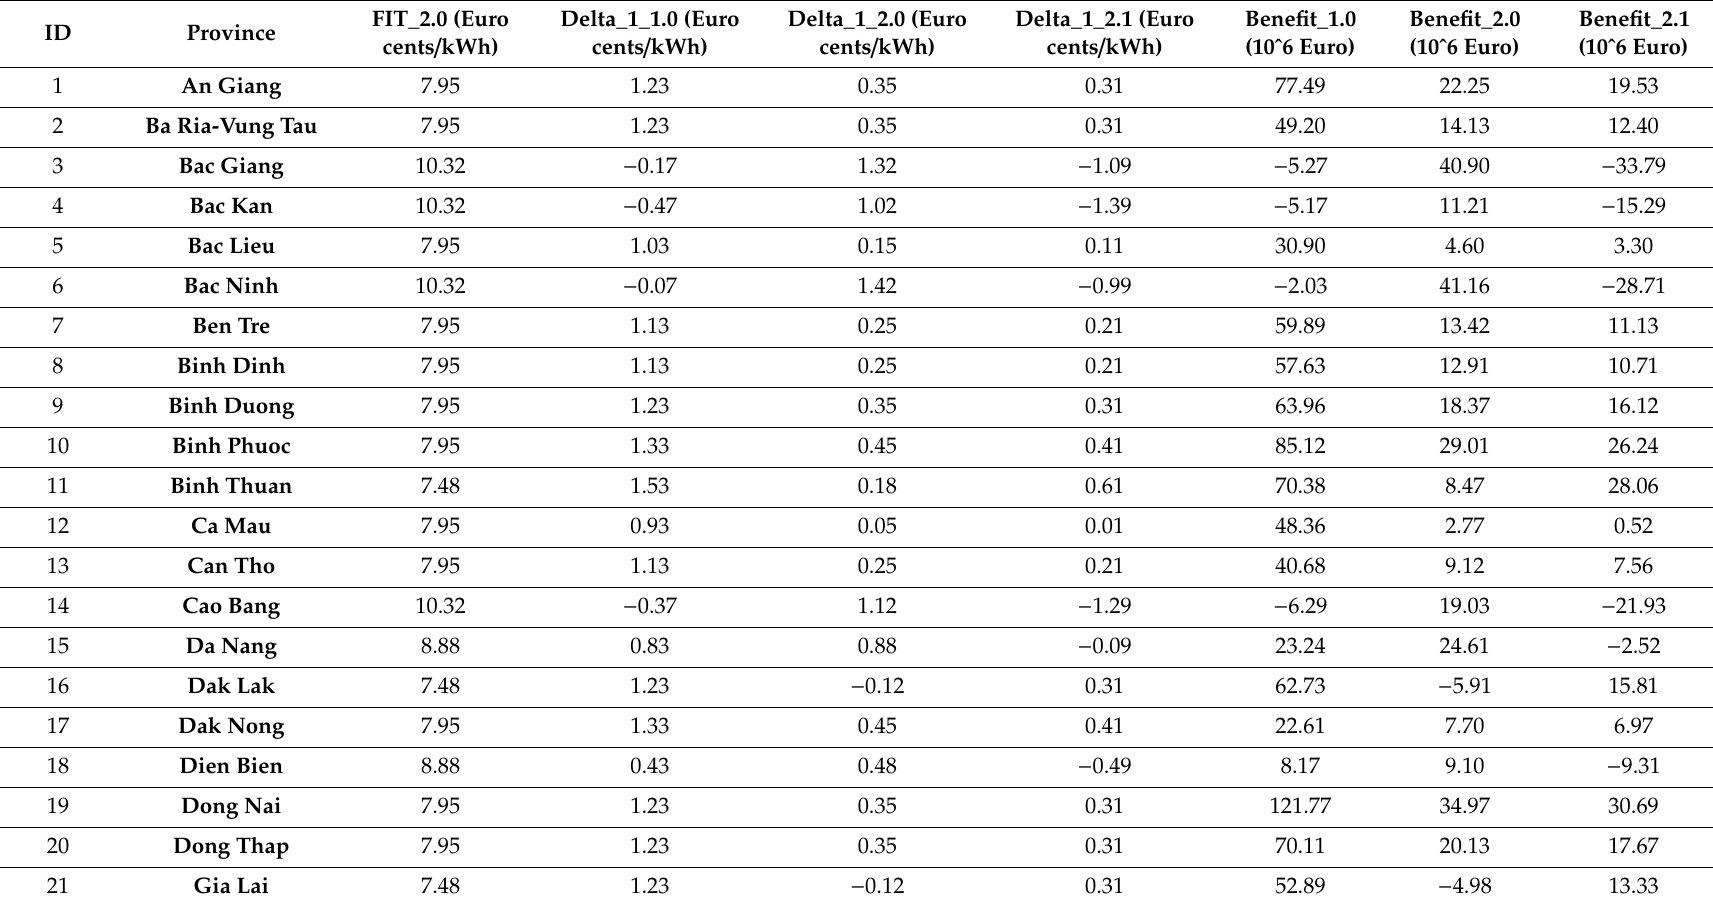
Table A5. Market benefit changes according to di ff erent FIT